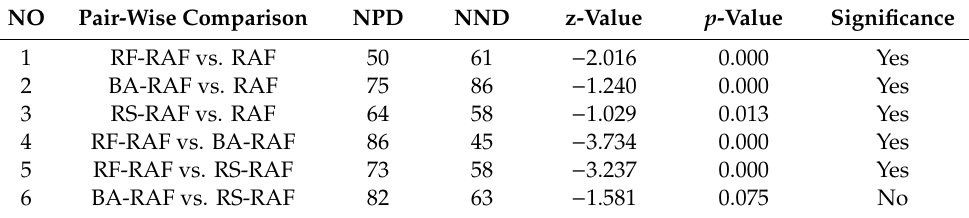
Table 6. Performance of the shallow landslide models based on the Wilcoxon signed-rank